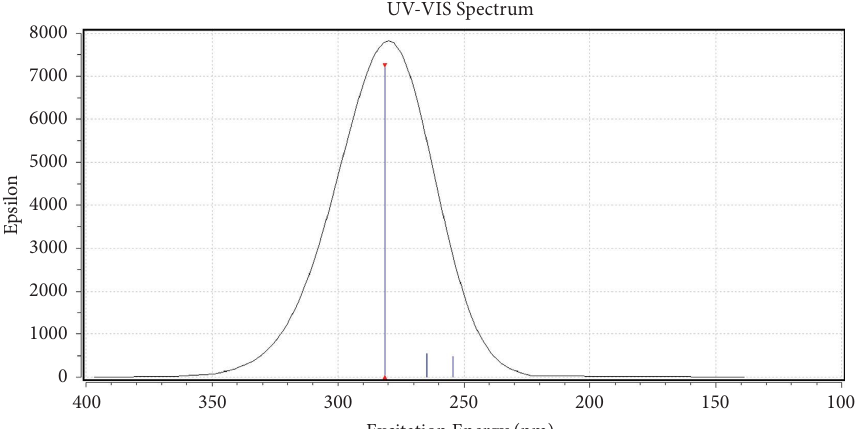
Figure 4: Te UV-visible spectrum of TFC obtained by the DT-DFT method at the B3LYP/6-311G(d,p) level of